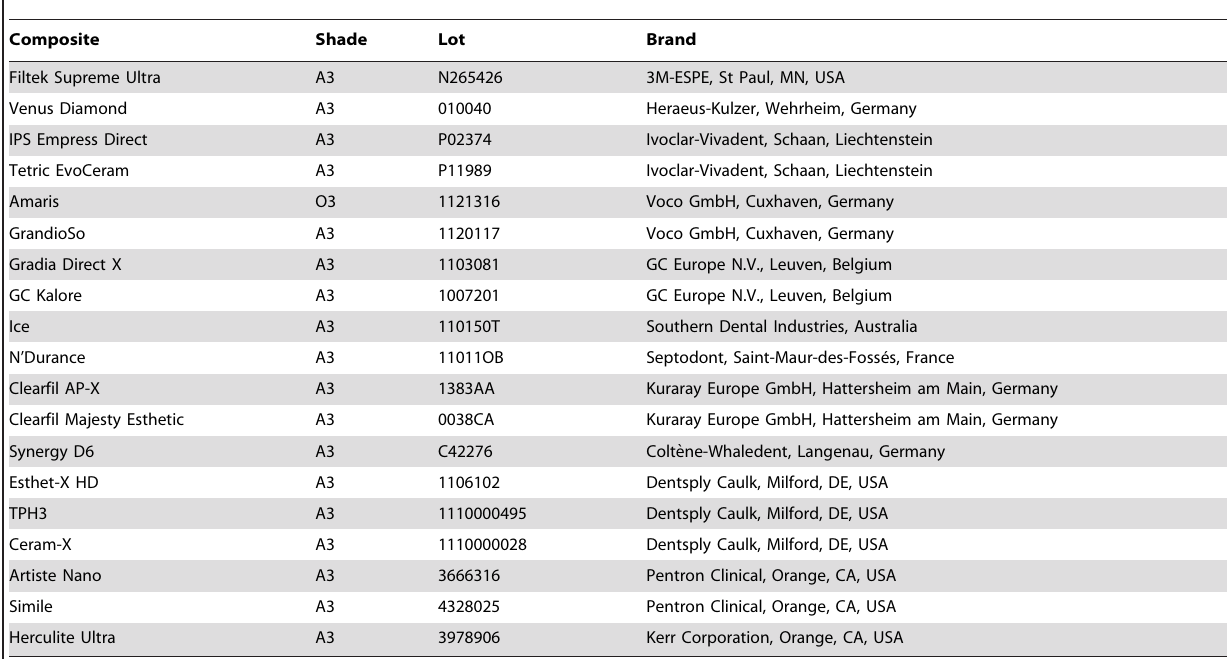
Table 1. Commercial composites selected for this study among the most widely used composites on the market.